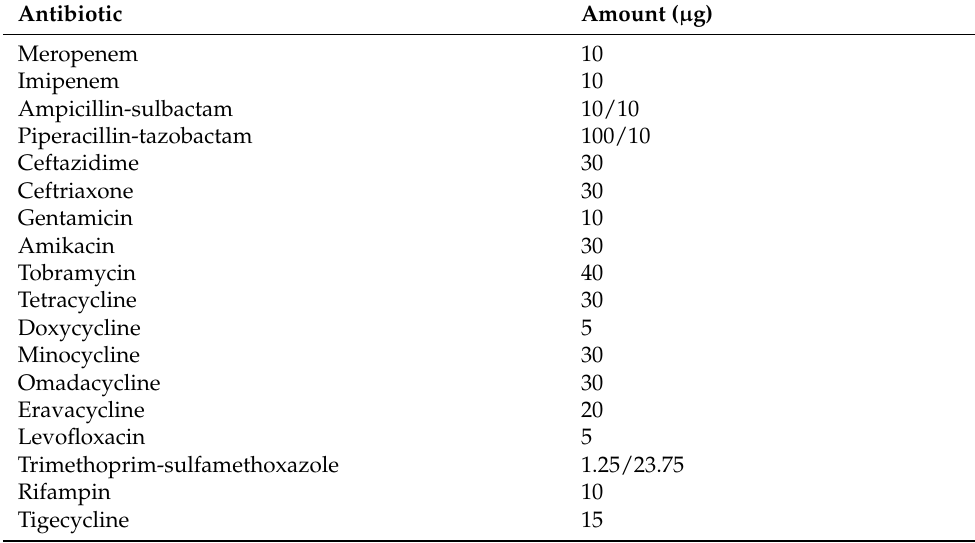
Table 3. Quantity of drugs used for disc